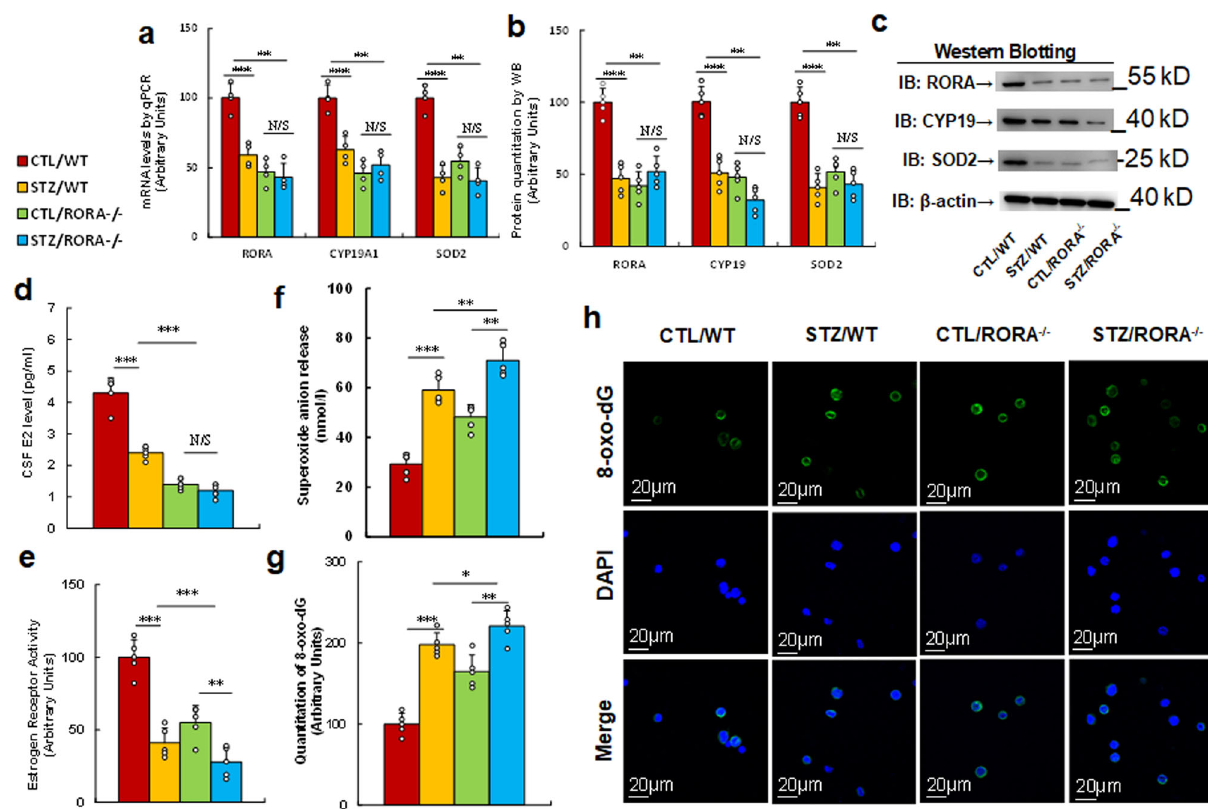
Fig. 4 Prenatal RORA de fi ciency mimics maternal diabetes-mediated oxidative stress. The RORA wild type (WT) or RORA null (RORA − / − ) backgrounds were used to generate either control (CTL) or STZ-induced diabetic (STZ) pregnant dams, and the amygdala neurons and/or tissues from subsequent male offspring were isolated for further analysis. a – d The amygdala tissues were isolated from 7- to 8-week-old male offspring for analysis. a The mRNA levels by qPCR, n = 4. b The quantitation of protein levels, n = 5. c The representative pictures for western blotting for ( b ). d CSF E2 levels, n = 9. e Estrogen receptor activity, n = 9. f In vivo superoxide anion release, n = 5. g , h The amygdala neurons were isolated on an embryonic day (E18) from the above treatment for immunostaining. g Quantitation of 8-oxox-dG staining, n = 5. h Representative pictures for 8-oxo-dG staining (green) and DAPI staining for nuclei (blue). ***, P < 0.0001; **, P < 0.001; *, P < 0.01; N/S, no signi fi cance. Data were expressed as mean ±